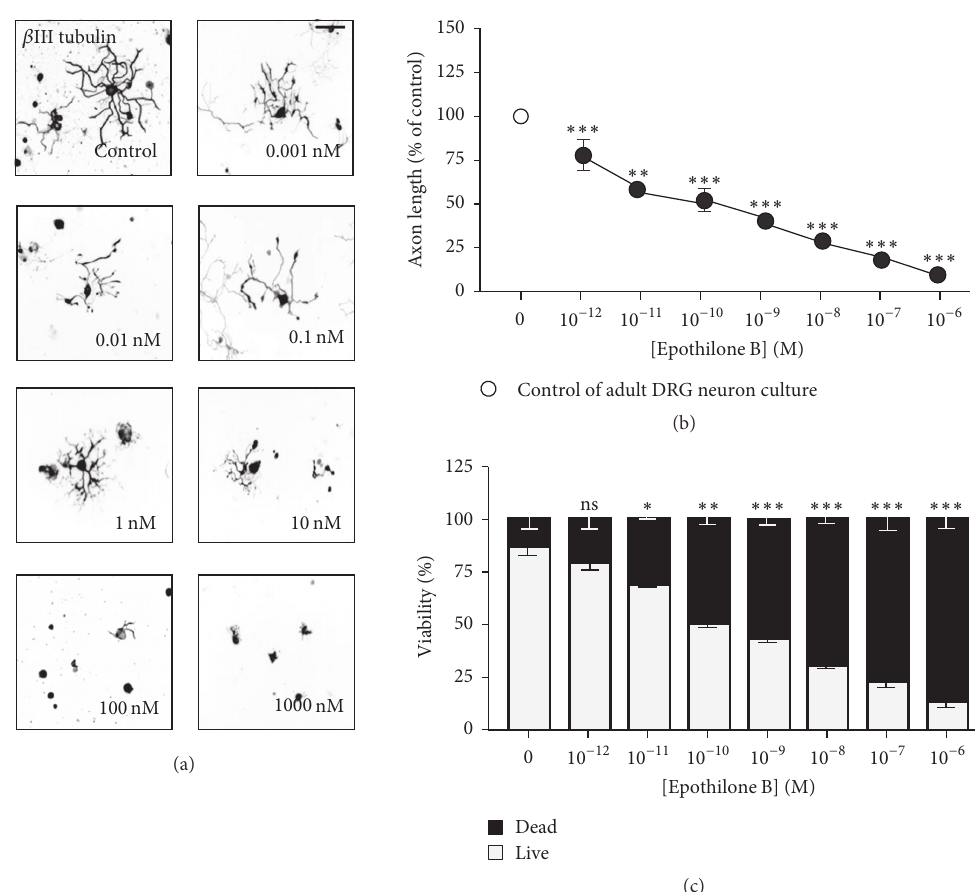
Figure4:EffectofepothiloneBonaxongrowthandcellviabilityinadultDRGneurons.(a–c)AdultDRGneuronswereplatedatalowdensity and cultured in the absence or presence of various concentrations of epothilone B, from 1pM to 1 𝜇 M, as indicated. Neurons were fixed at 24 hr after plating and immunostained with anti-Tuj1 antibodies. Representative images ((a), inverted images from Tuj1 immunostaining) and quantification of axon length (b) are shown. Cell viability was assayed by PI staining (c). Scale bar, 100 𝜇 m. ∗ 𝑝 < 0.05, ∗∗ 𝑝 < 0.01, and ∗∗∗ 𝑝 < 0.001; ns, statistically not